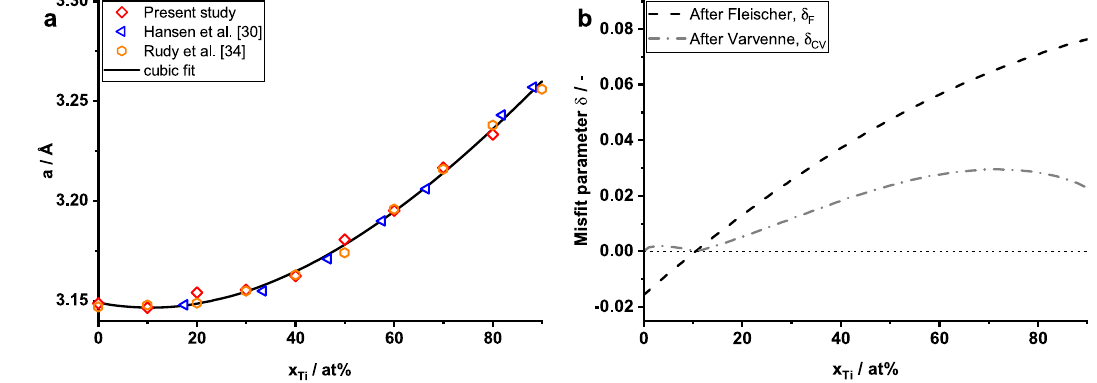
Fig. 1 Lattice parameter and mis fi t in Mo-Ti solid solutions. a Lattice parameter a of Mo-Ti solid solutions as a function of the Ti concentration x Ti . Present study (red symbols) in comparison to results by Hansen et al. (blue) 30 and Rudy et al. (orange) 34 and a cubic fi t (black line). b The lattice mis fi t parameters for the Mo-Ti system based on the cubic fi t from a after Fleischer 16, 22 (black dashed line) and after Varvenne 17 (gray dash-dotted line). The dotted line indicates zero mis fi